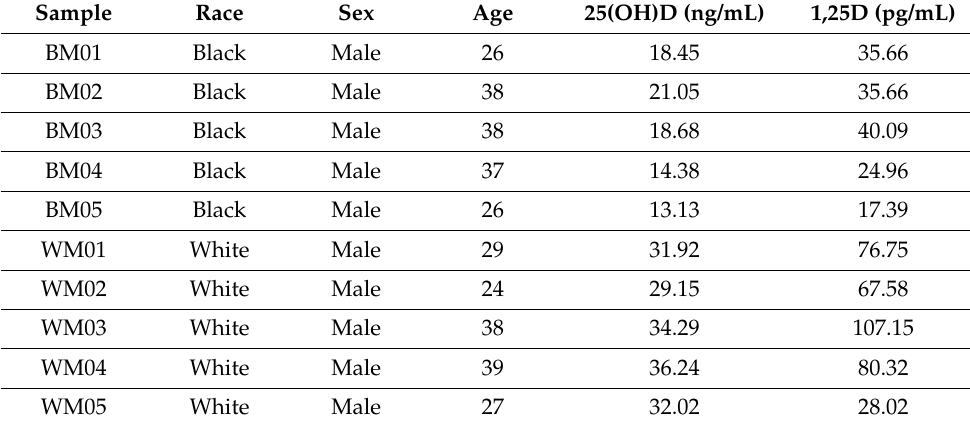
Table 1. Demographic and vitamin D metabolite data of donor specific serum.